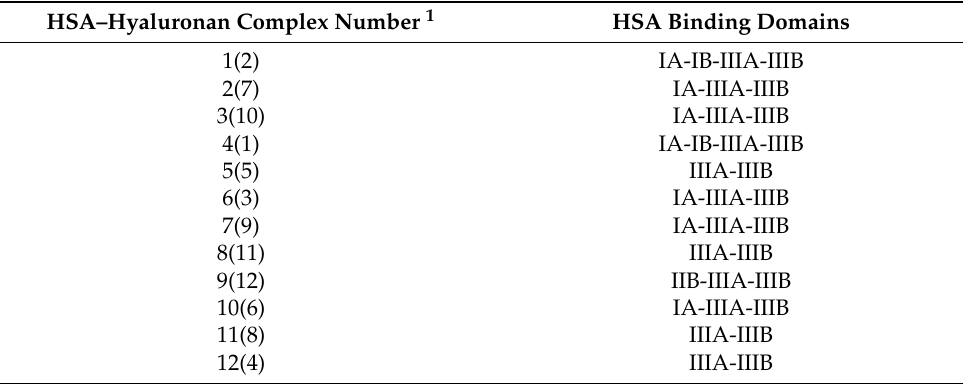
Table 1. The MD and docking ranks of potential HSA–hyaluronan